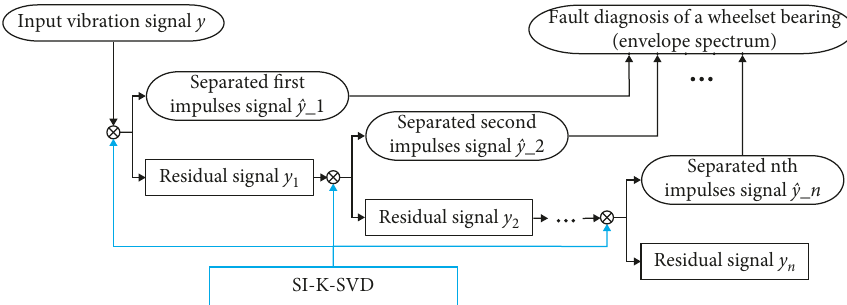
Figure 1: Procedure of H-SI-SVD for multifault impulsive component separation.